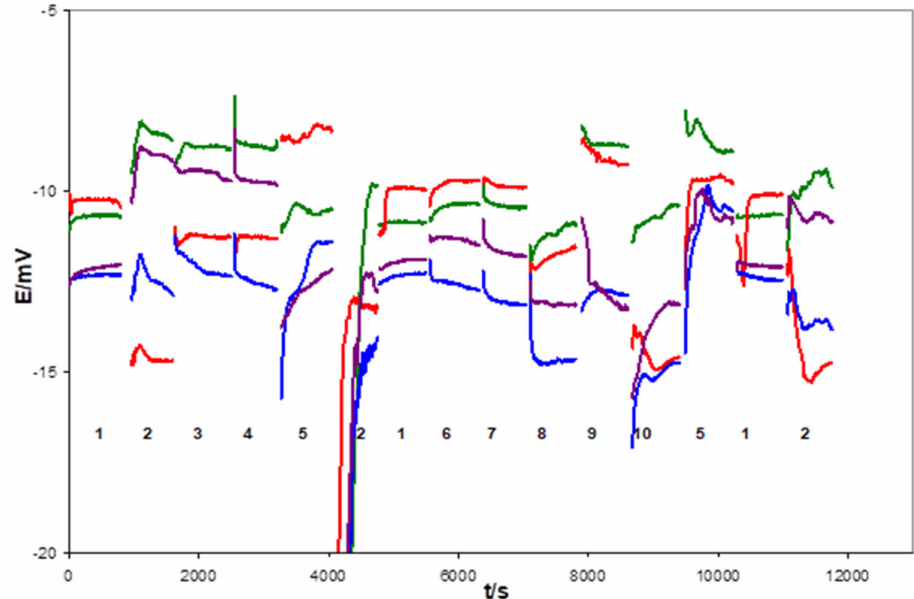
Figure 4. Potential changes of the type electrodes recorded during multi-solution testing subsequently performed in indicated solution: 1—3 M KCl, 2—H 2 O, 3—0.01 M NaCl, 4—0.01 M KCl, 5—0.01 M HCl, 6—0.1 M NaCl, 7—0.1 M KCl, 8—0.1 M NaBr, 9—0.1 M NaHCO 3 , 10—0.001 M KOH. The mean potential values for these electrodes were equal to: − 9.91 ± 0.88 mV, − 11.30 ± 2.16 mV, − 12.88 ± 1.12 mV, and − 11.61 ± 1.30